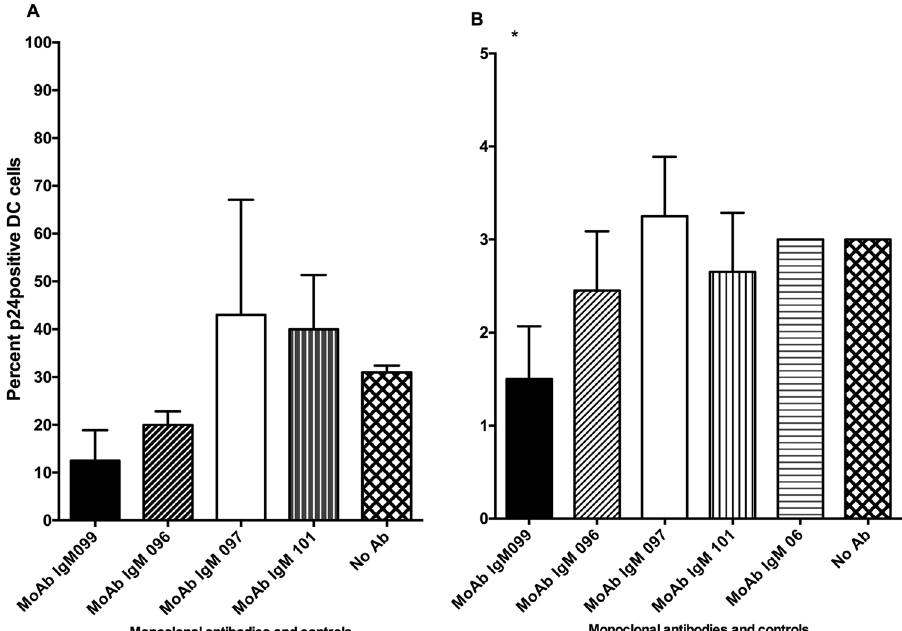
Figure 6. Effect of anti-HIV IgM antibody in cervix biopsies on the percentage of HIV-1 p24 + dendritic cells (DC). ( A ) The percentage of p24 + DCs in endocervical tissue and ( B ) the percentage of p24 + DCs in ectocervical tissue after 24 h of HIV-1 with and without monoclonal antibody exposure in vitro . The bars illustrate the range from duplicate inhibition assays. Mann Whitney U test was used to determine if the samples were significantly different than the negative control ( * p = <